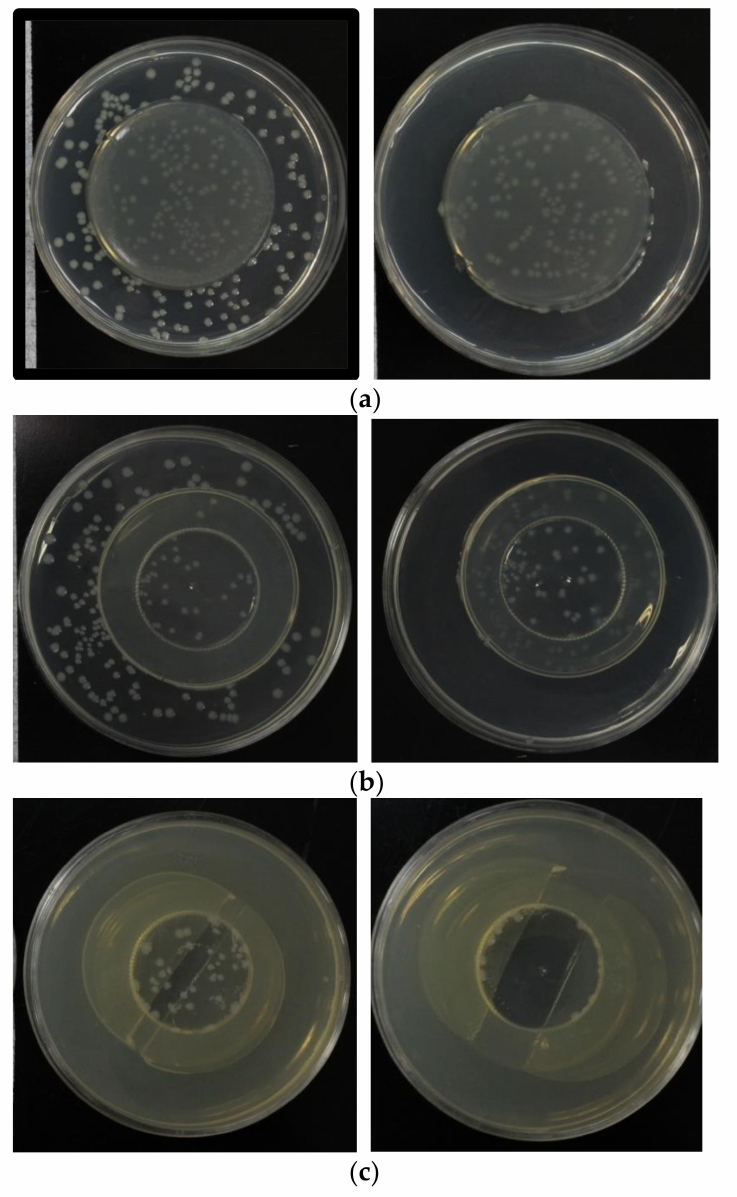
Figure 9. Appearances in each configuration. ( a ) Configuration (2); ( b ) configuration (3); ( c ) configura- tion (4), (5); The figures of left side are control. The figures of right side are after applying